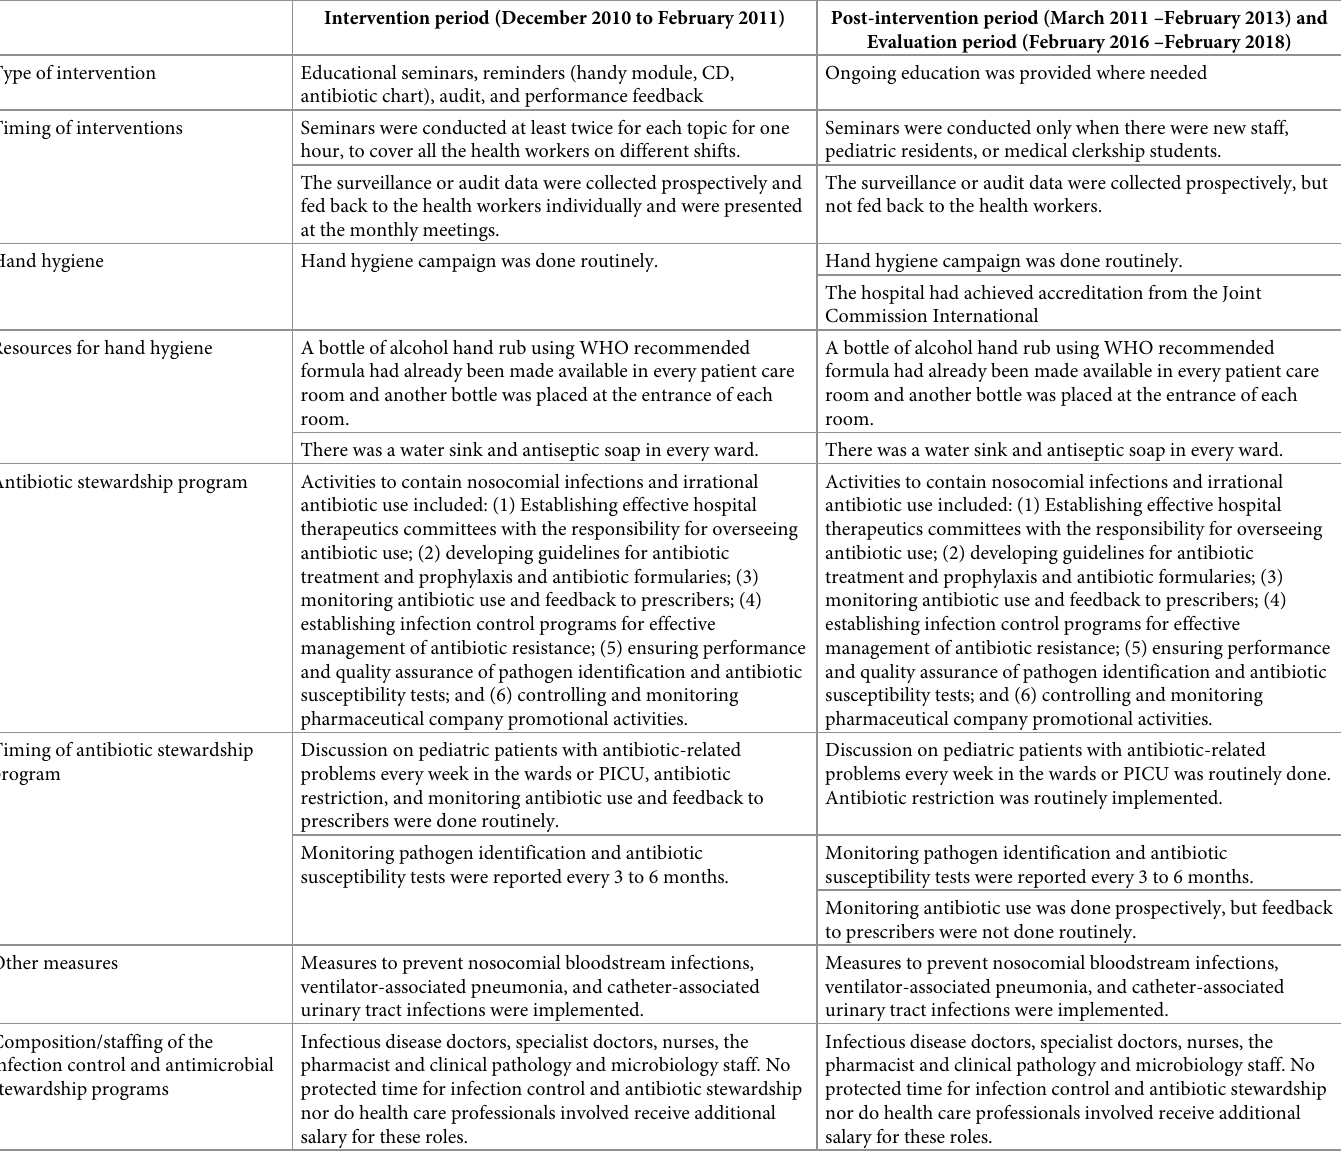
Table 1. Interventions and activities done in each period of the